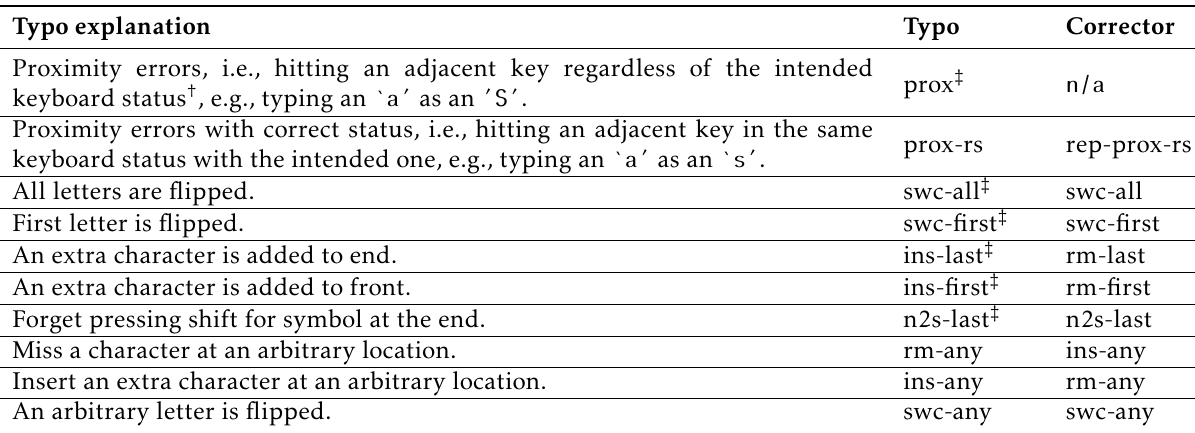
Table 1. Top typos and their correspondingcorrectors.